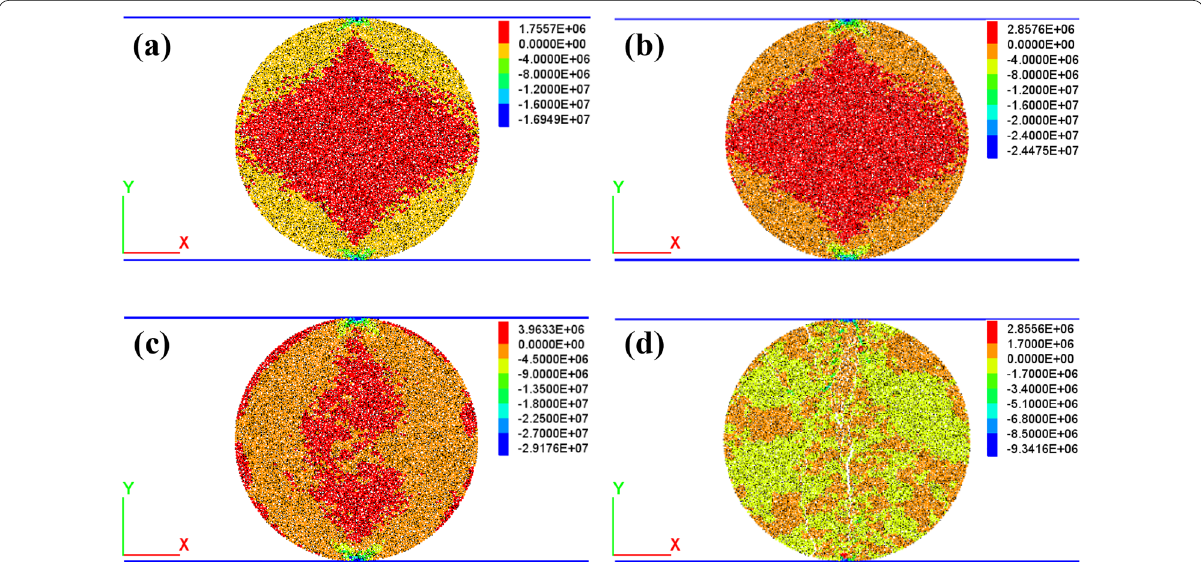
Fig. 16 Horizontal stress state when the water–cement rate was 0.35: a 50% tensile strength; b 80% tensile strength; c 100% tensile strength; d after tensile strength.